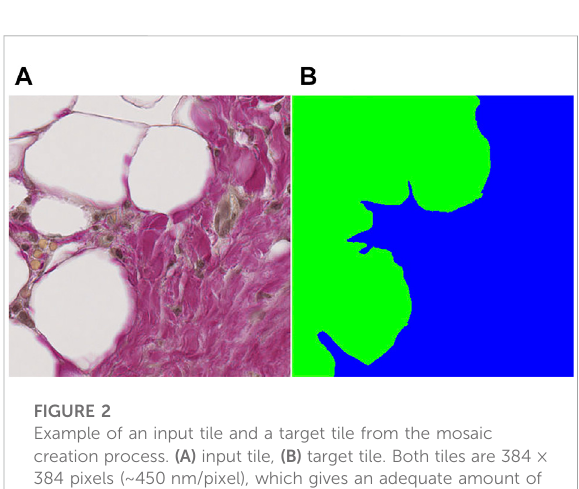
FIGURE 2 Example of an input tile and a target tile from the mosaic creation process. (A) input tile, (B) target tile. Both tiles are 384 × 384 pixels (~450 nm/pixel), which gives an adequate amount of information aboutthe tissue for determining theclass label(s) in the fi eld of